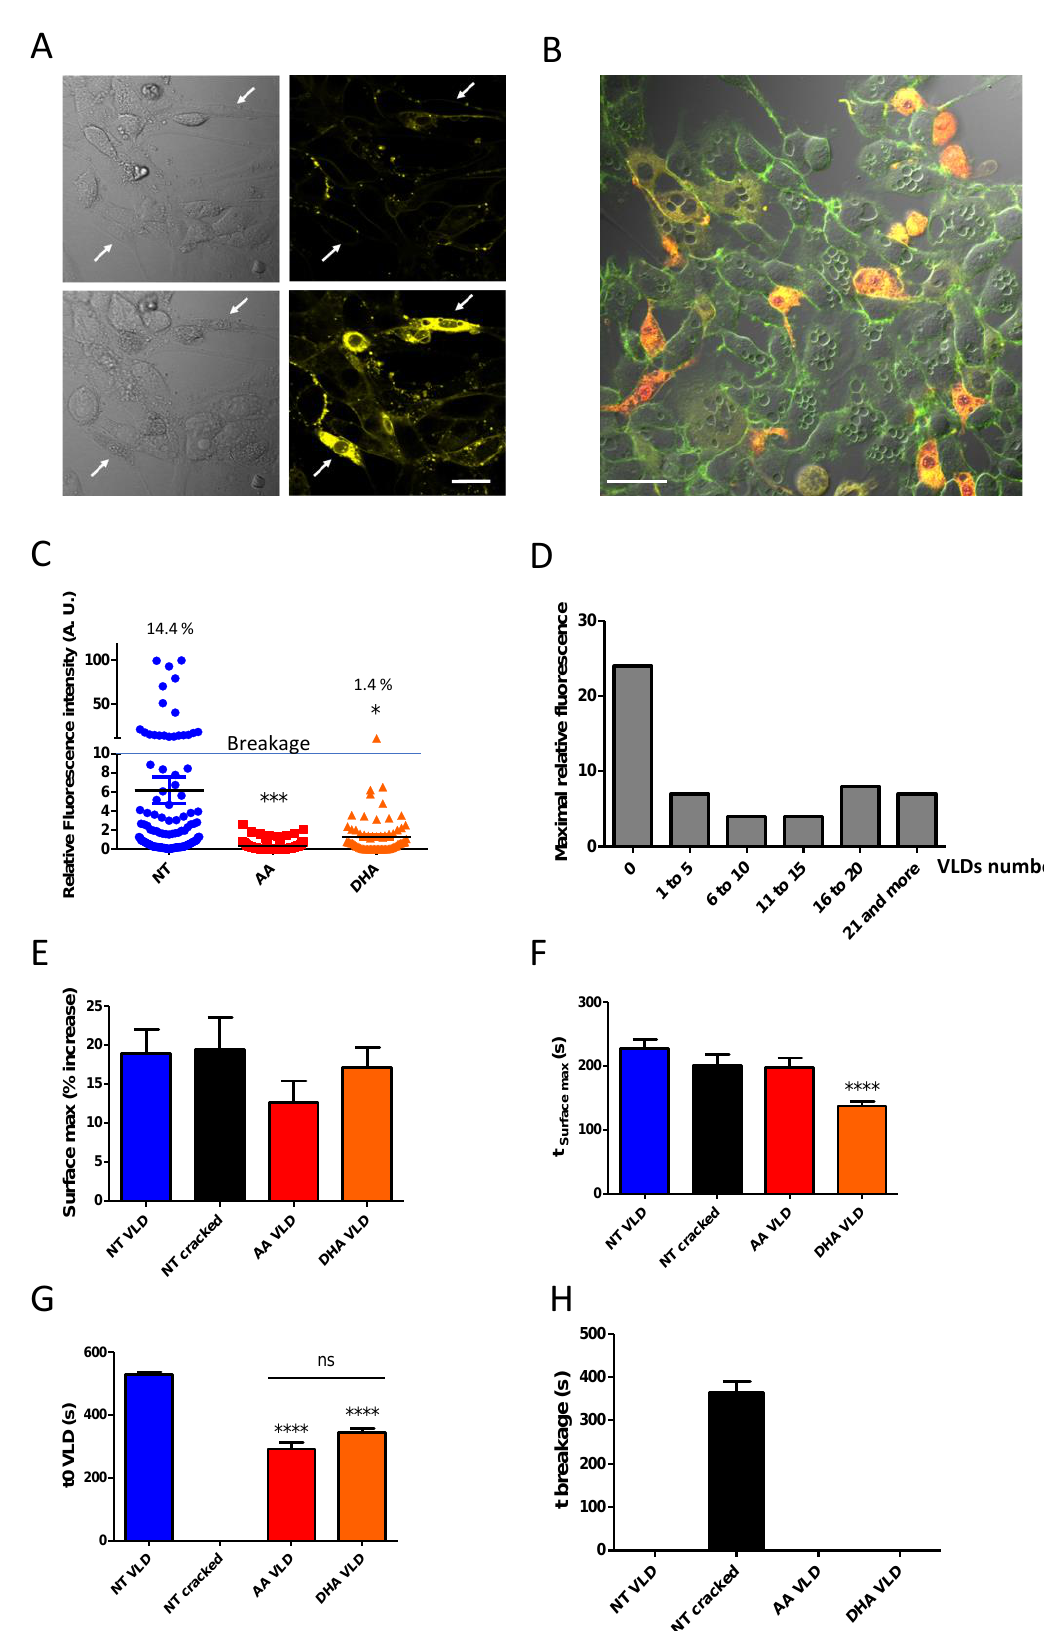
Figure 6. VLD formation limits cell breakage in a process that is modulated by the fatty acid composition of membrane phospholipids. ( A ) Examples of cell breakage following osmotic downshock: when the integrity of the cell membrane is lost, FM1-43 rapidly fills the cytoplasm and generates an intense fluorescence at 543 nm. Representative transmission (left) and fluorescence (543 nm) images (right) of FM1-43-labeled myoblasts before (above) and after (below) osmotic downshock. White arrows designate two cell breakages (for dynamic view, see Movie S2). Scale Bar: 20 µm. ( B ) Composite image of fluorescence images recorded at 515 and 543 nm showing both VLDs and cells with high yellow fluorescence. Scale Bar: 20 µm. ( C ) Relative fluorescence intensity at 543 nm obtained at the end of the osmotic downshock. The %